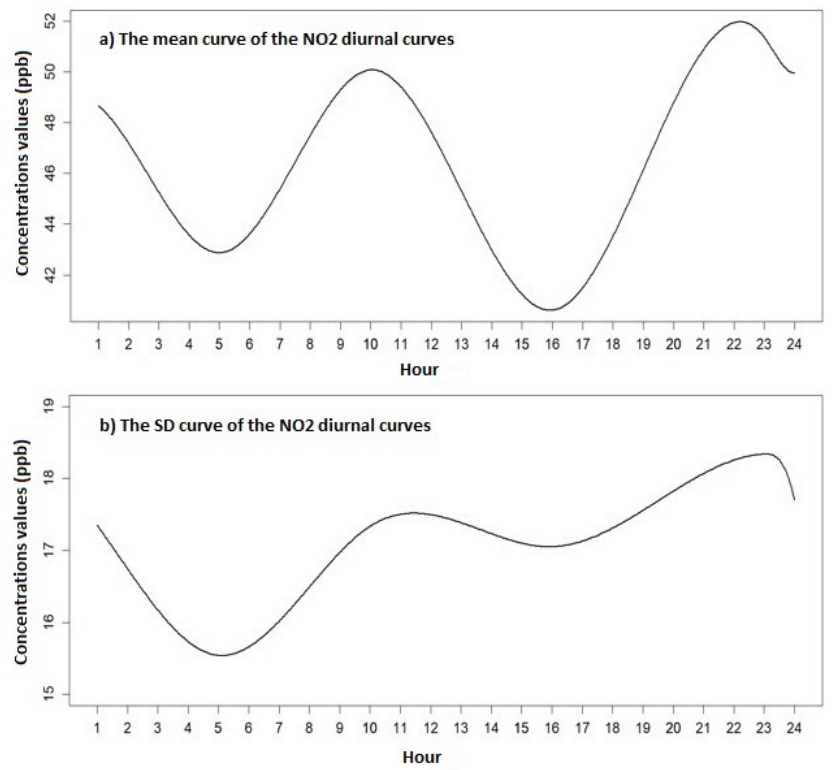
Figure 3. The mean ( a ) and the standard deviation ( b ) curves of the smoothed diurnal NO 2 (ppb) curves at the monitoring stations in Tehran.